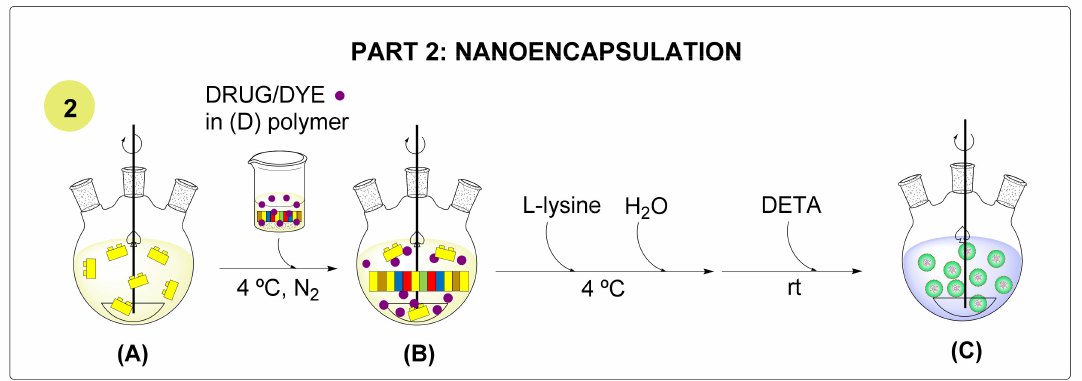
Scheme 2. Graphic representation of the nanoencapsulation